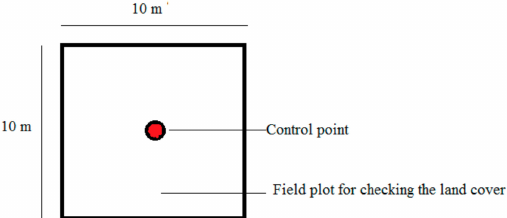
Figure 5. The control point and the field plot for checking the non-forest land